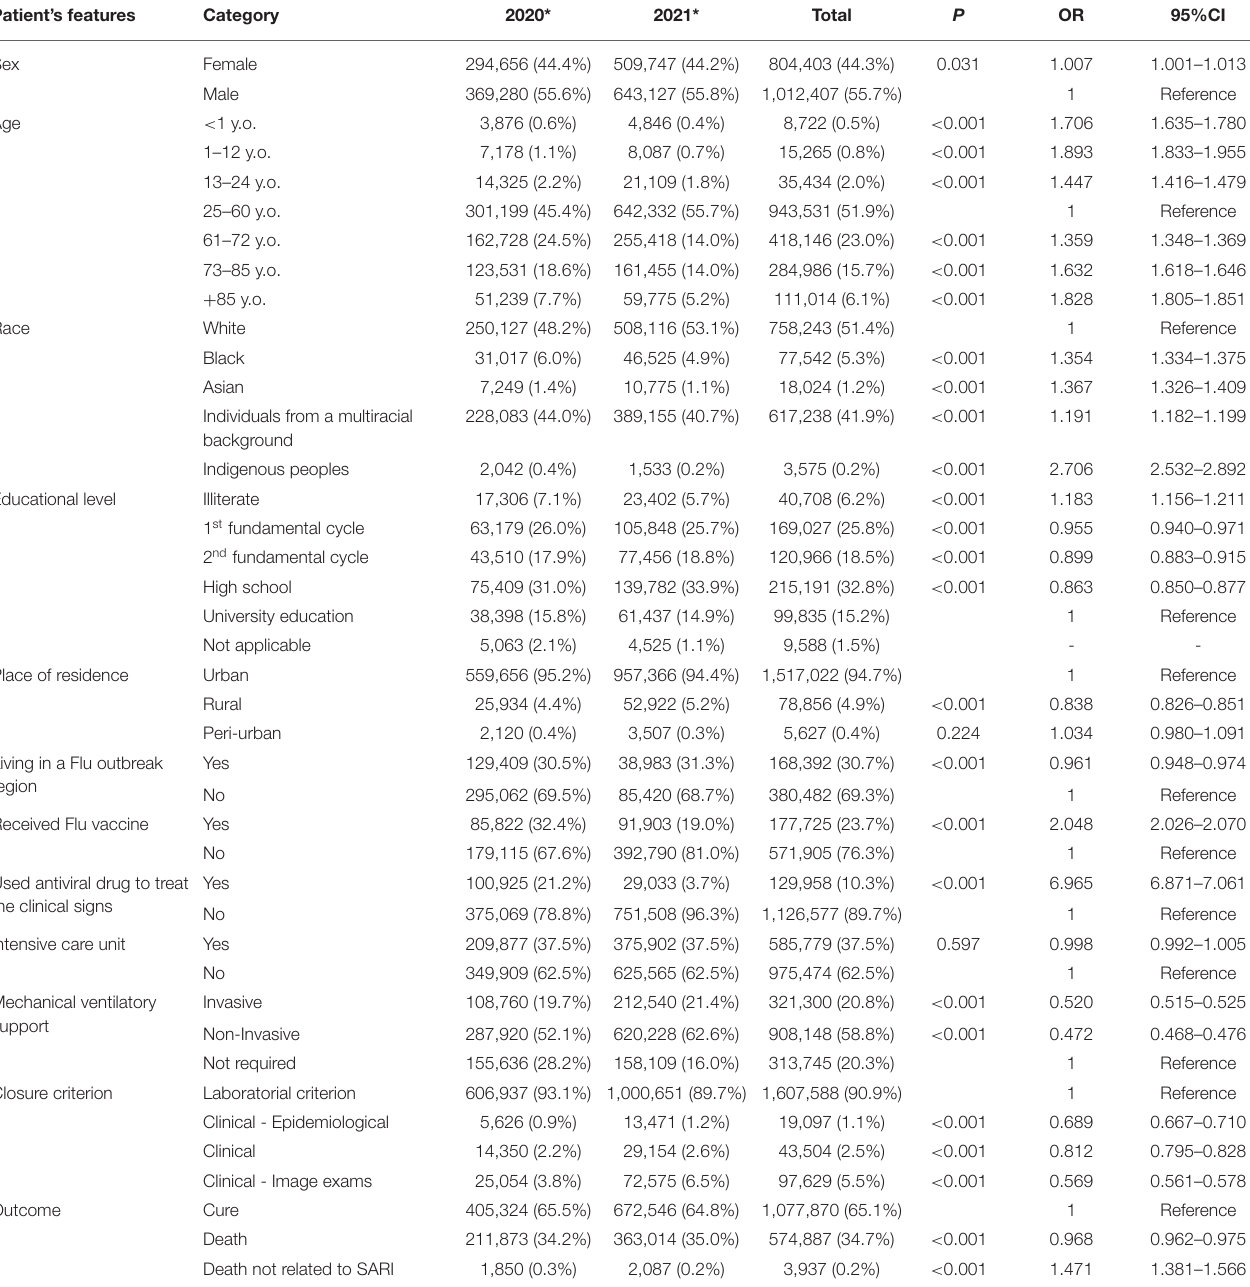
TABLE 7 | Association between features of the hospitalized patients due to severe acute respiratory infection (SARI) in Brazil due to the Coronavirus Disease (COVID)-19 according to the data collection period. Patient’s